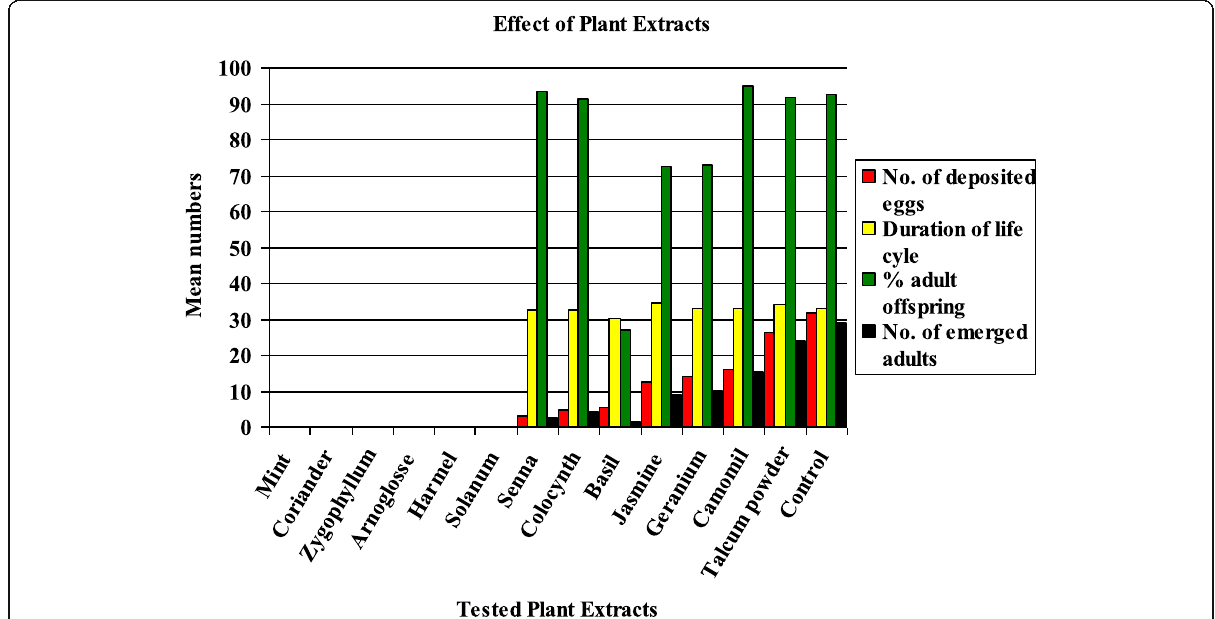
Fig. 1 Effect of botanical extracts on some biological parameters of Phthorimaea